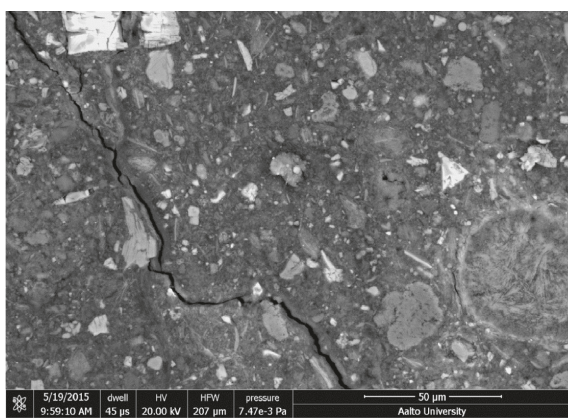
Figure 7: BSE-SEM images of 28-day old mix MSOMgO